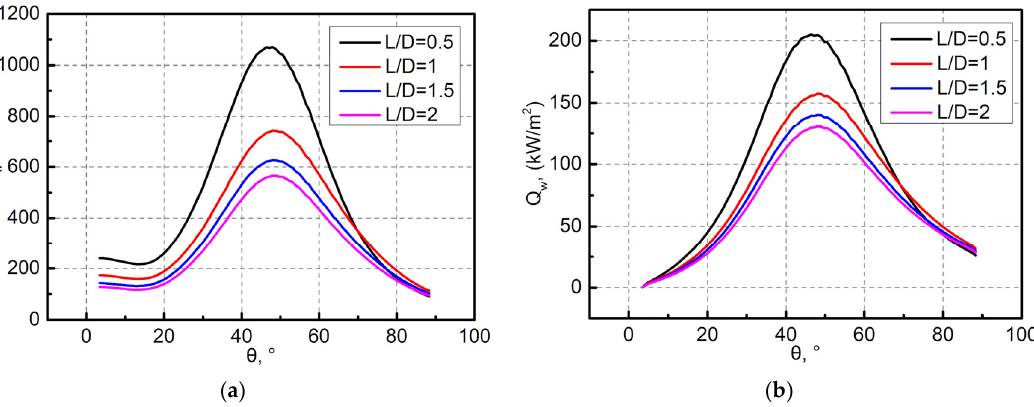
Figure 16. Initial pressure and heat flux of the forebodies with different lengths L : ( a ) pressure; ( b ) heat flux. Table 10. Comparison of the initial total drag coefficient and peak heat flux of the forebody.